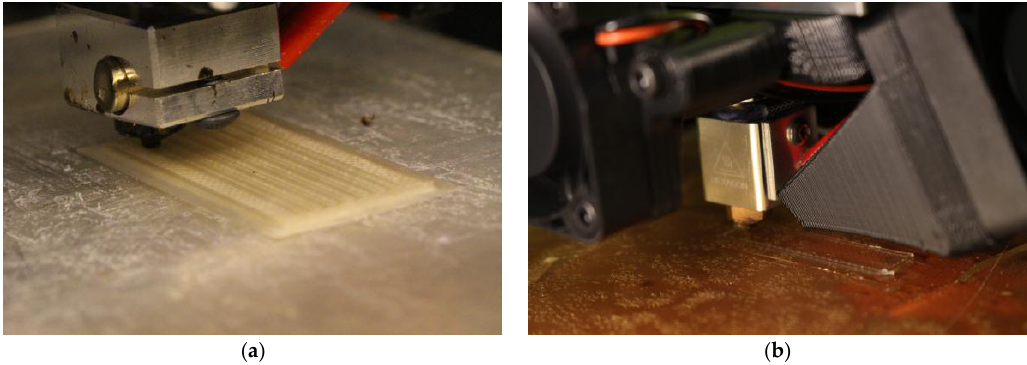
Figure 5. A precursor Nafion membrane printed with inner channels for potential implementation of liquid sensors ( a ) and a precursor Aquivion membrane being printed in typical dimensions for IPMC applications ( b ).